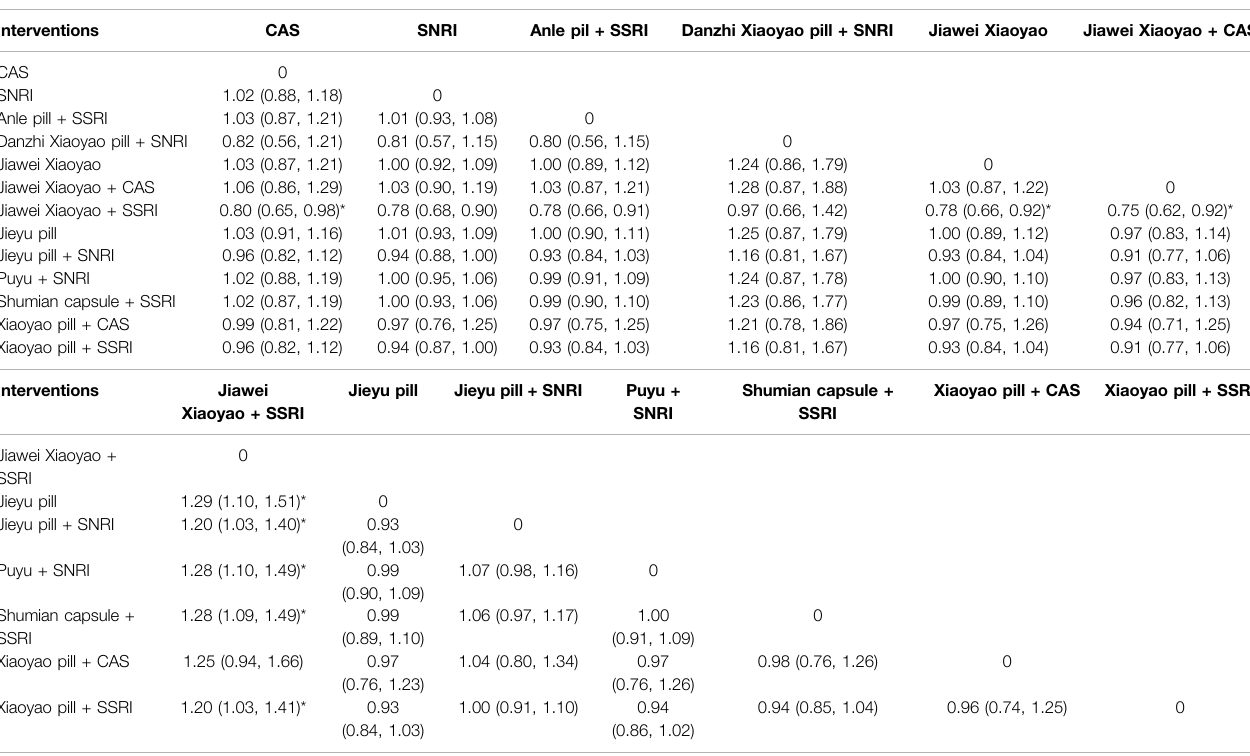
TABLE 2 | Network meta-analysis of total effective rate RR (95%CI). Interventions